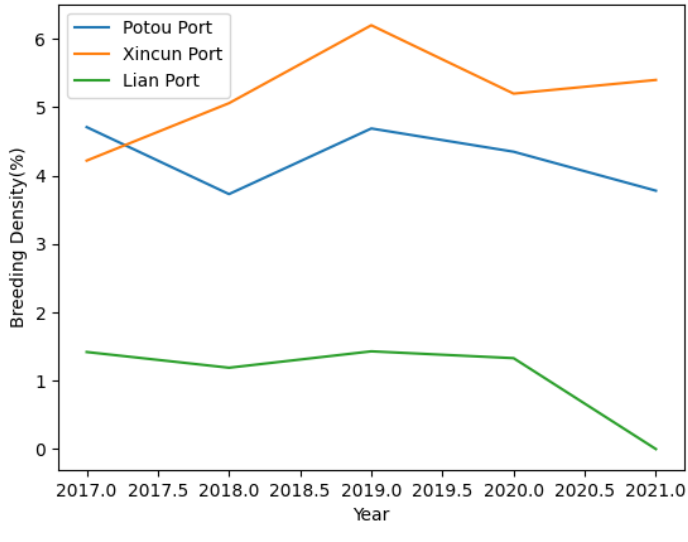
Figure 8. Breeding density.